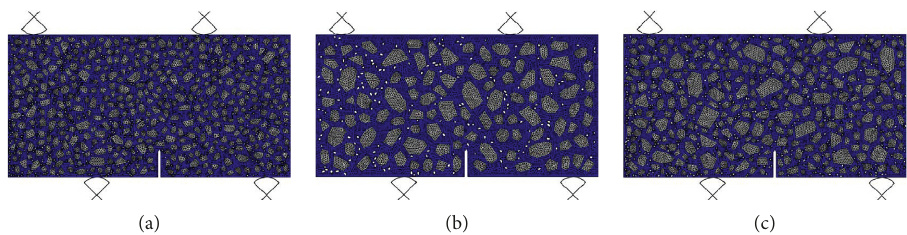
Figure 5: Model diagram of the maximum size of the coarse aggregate. (a) D